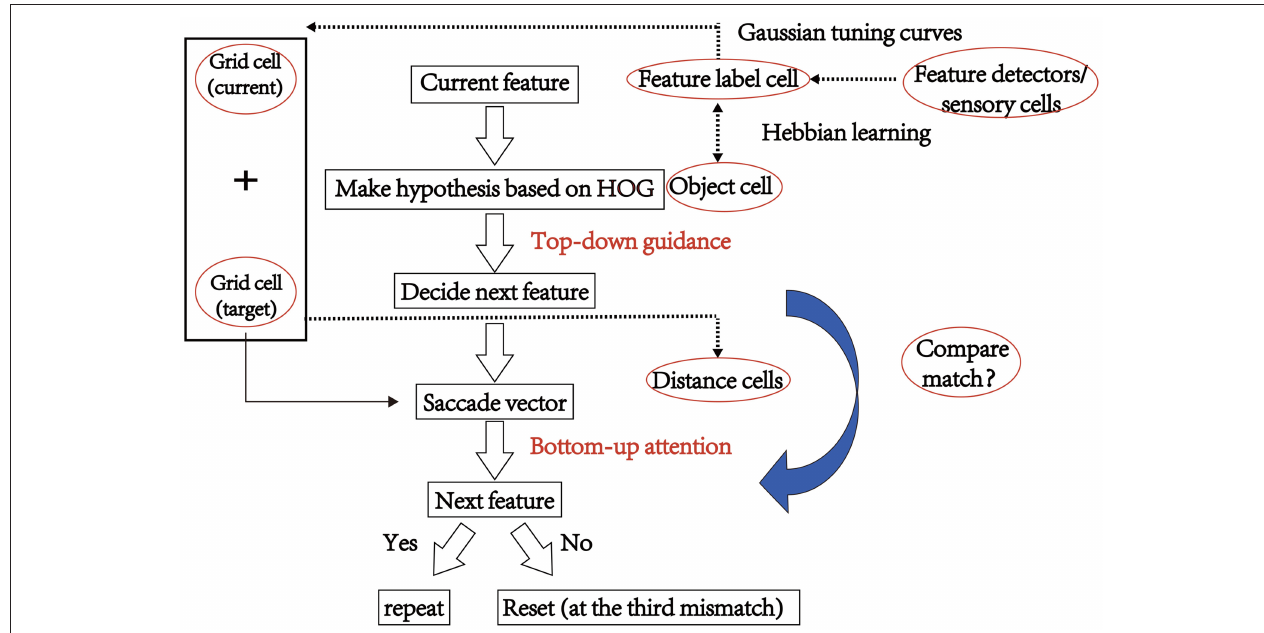
FIGURE 6 | The schematic of our model based on the grid cells and HOG algorithm.